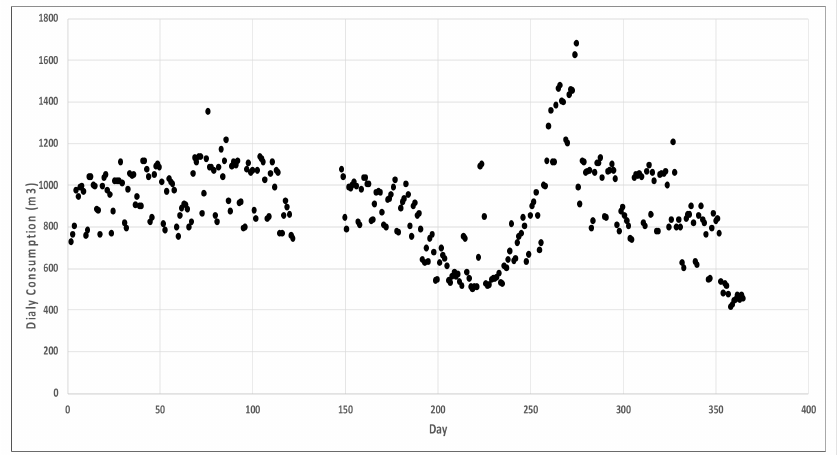
Figure 16. Variation of the daily water consumption (Qd) of the Scientific Campus in 2015.